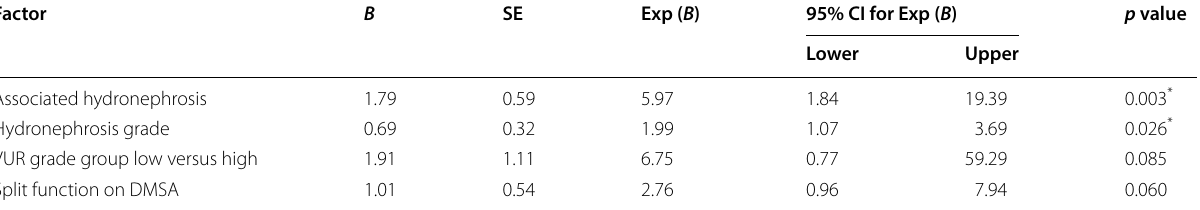
* Significant Statistical analysis using Cox proportional hazards